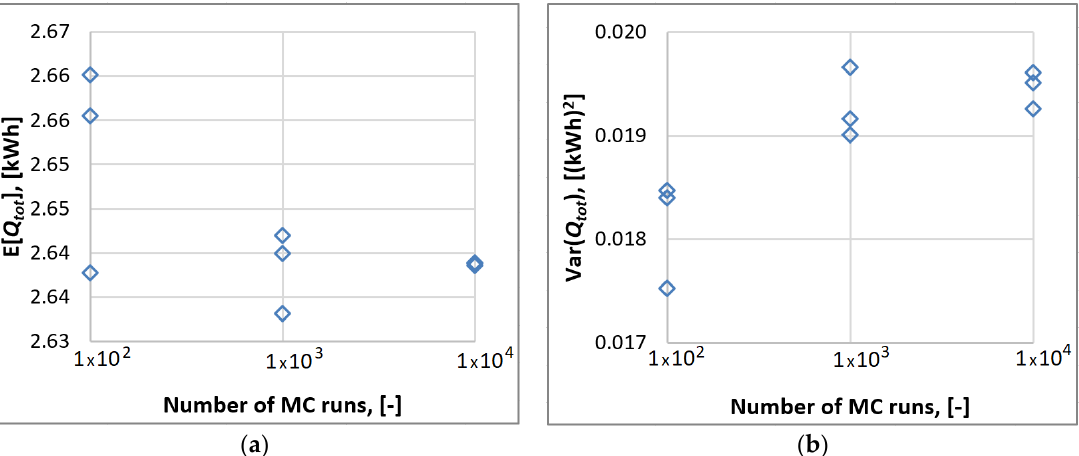
Figure 6. Comparison of ( a ) expected values and ( b ) variance of the total heat flux in January obtained using the Monte Carlo method for different number of the Monte Carlo runs for Case 2.